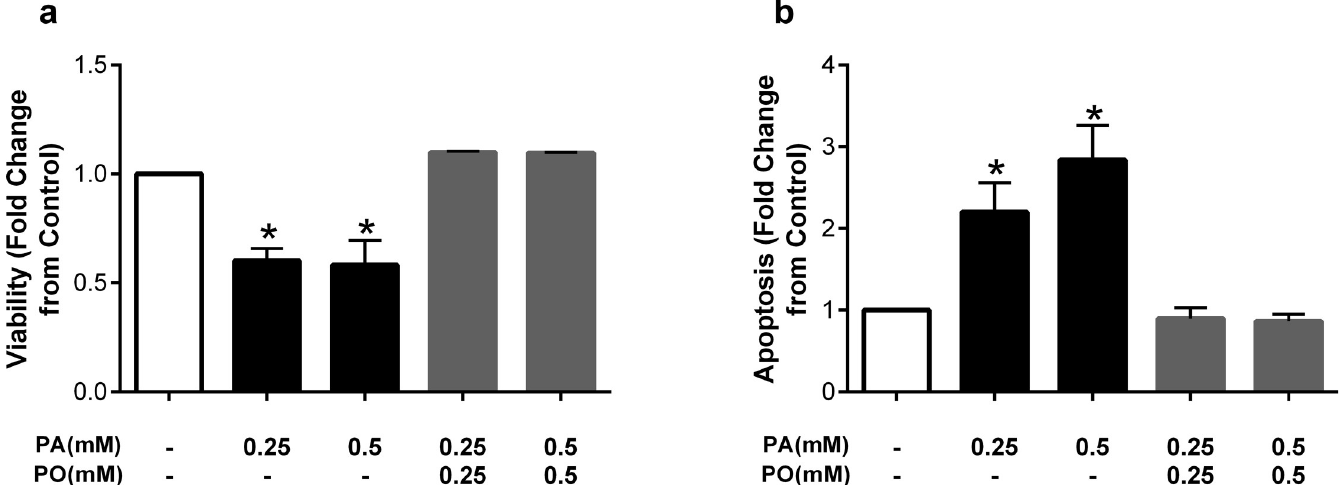
Fig 3. The monounsaturated fatty acid palmitoleate prevents detrimental effects of palmitate. Fold change from control in a) viability and b) apoptosis after treatment with palmitate (PA) at 0.25 or 0.5mM, or co-treatment with the unsaturated fatty acid palmitoleate (PO). Data are expressed as mean ± SEM; n = 4–6 independent experiments; � p < 0.05 vs